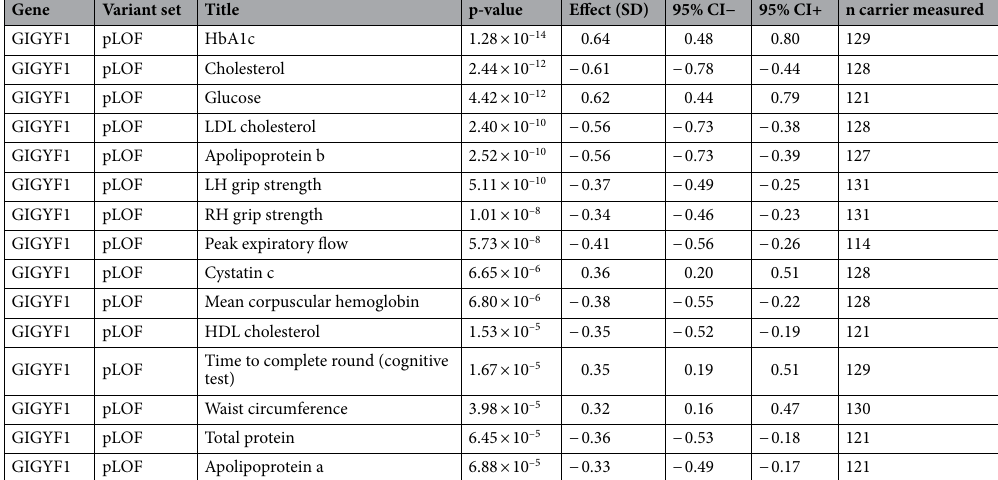
Table 4. PheWAS of GIGYF1 pLOF – quantitative traits. Significant associations with quantitative traits are shown (p ≤ 1.22 × 10 –4 ). Effect is shown in standard deviations (SD) of transformed values. RH right hand, LH left hand, CI confidence interval.